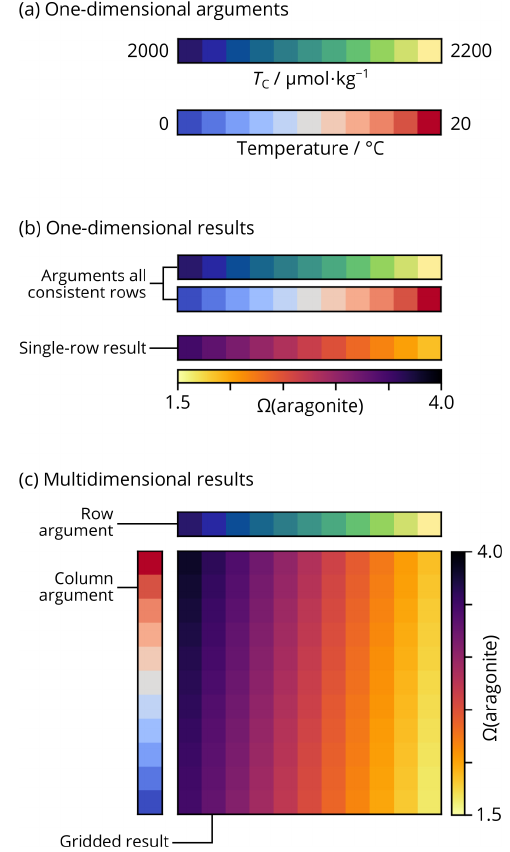
Figure 2. Schematic representation of broadcasting array shapes with NumPy in PyCO2SYS. (a) Two of the arguments to PyCO2SYS are provided as arrays, each containing 11 different values for T C and temperature. Other arguments could be similarly shaped vectors or single scalar values. (b) If the array arguments were all provided as one-dimensional rows, then the calculated re- sults (e.g. aragonite saturation state) would also be one-dimensional rows. Each element of the results array corresponds to the element in the same position in each argument array. For scalar arguments, the same value is used across each result array. (c) If the array ar- guments are provided as a mixture of rows and columns, then the results are calculated on a broadcasted grid including every com- bination of the arguments’ elements. The same principle applies to arguments and results of arbitrarily higher